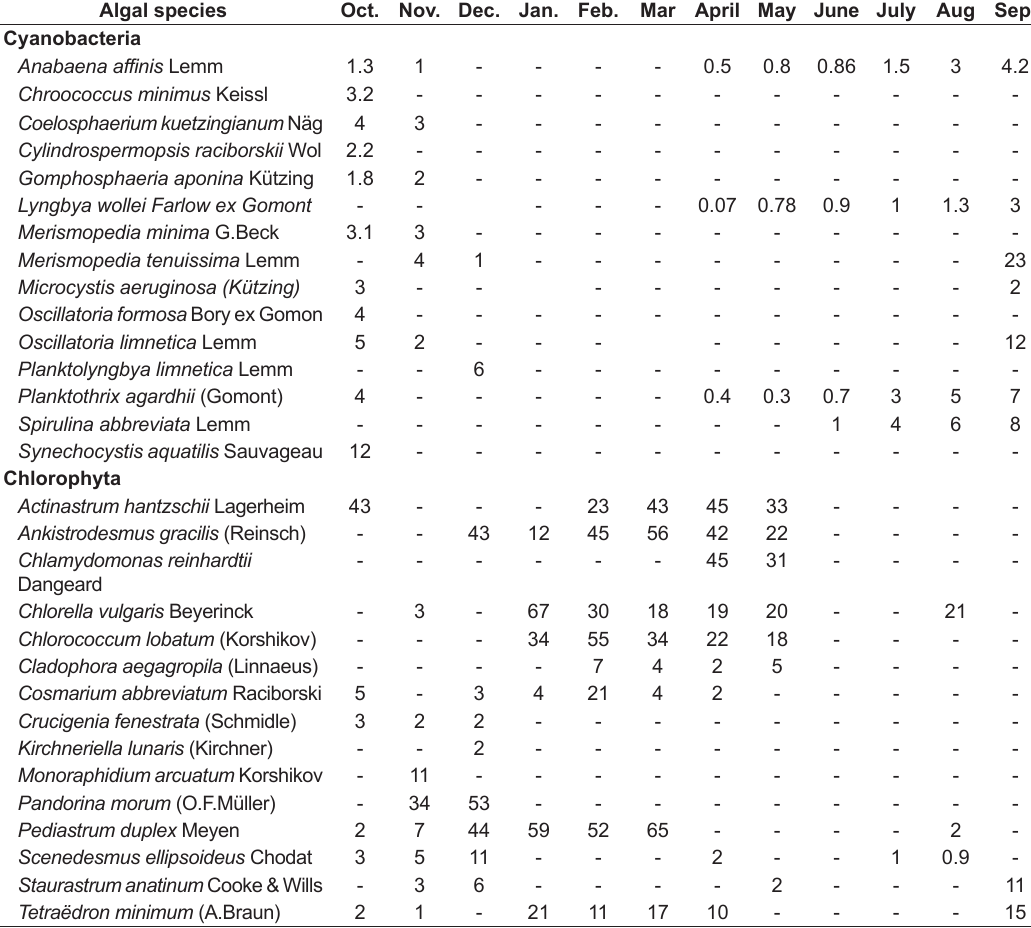
Table 2. Analysis of different phytoplankton groups identified in fish gut (cells x10 6 gut -1 ) from fishpond 1 during the study period Oct. 2012- Sept. 2013. Oct. Nov. Dec. Jan. Feb. Mar April May June July Aug